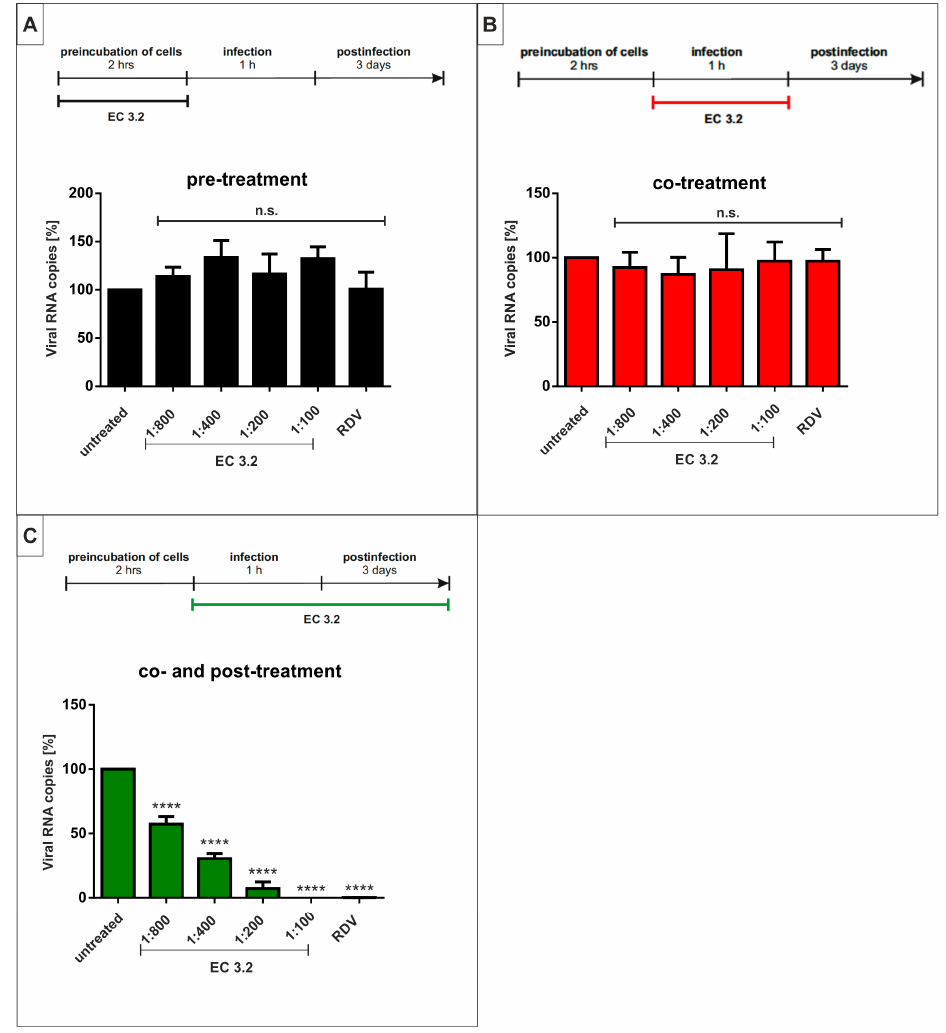
Figure 7. Treatment with EC 3.2 before or during the infection with SARS-CoV-2 has no influence on viral replication. ( A ) Time of addition (TOA) of EC 3.2 with the indicated dilutions. Calu-3 cells were preincubated with EC 3.2 for 2 h following two washing steps with PBS. ( B ) The TOA of EC 3.2 was only during infection of Calu-3 cells for 1 h. ( C ) The TOA of EC 3.2 was during infection of cells for 1 h and following removal of input virus, for 3 days post-infection. ( A – C ) Cells were infected with the clinical isolate SARS-CoV-2 PR-1 at a MOI of 2 × 10 − 2 for 1 h. A total of 1 μ M RDV was included as a positive control. Cell culture supernatants were harvested at 3 dpi. The virions were purified and analyzed by qRT-PCR. Bars show mean values of three independent experiments ± standard deviation. Statistical analysis was performed using a multiple comparison Kruskal– Wallis test (Anova) followed by Dunn’s post hoc test (n.s. = not significant; **** p < 0.0001 versus the untreated control).